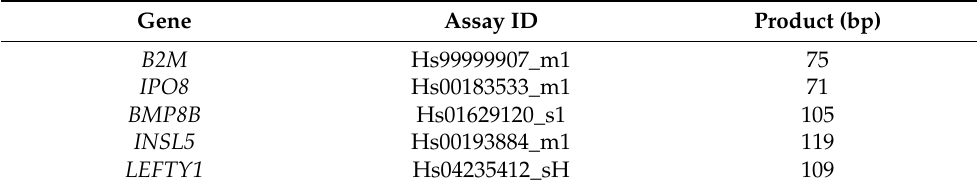
Table 3. TaqMan Gene Expression Assays used in experiment. bp, base pairs.